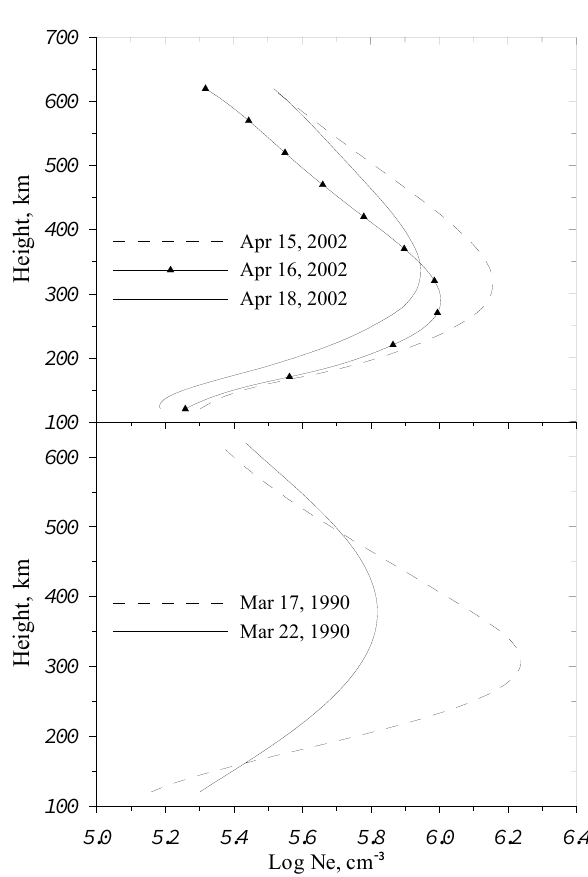
Fig. 7. Observed smoothed Ne(h) profiles for the periods given in Tables 1 and 3. The effective scale height of Ne(h) distribution for 16 April 2002 is close to H eff for the reference day of 15 April 2002 and the negative effect takes place in the whole F2-region for the Q- disturbance event. In the case of the usual negative disturbances on 18 April 2002 and 22 March 1990 the negative effect is localized around the F2-layer maximum.